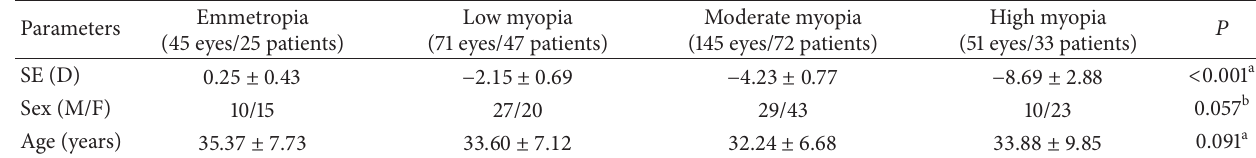
Table 1: Baseline data of the four diagnostic groups.